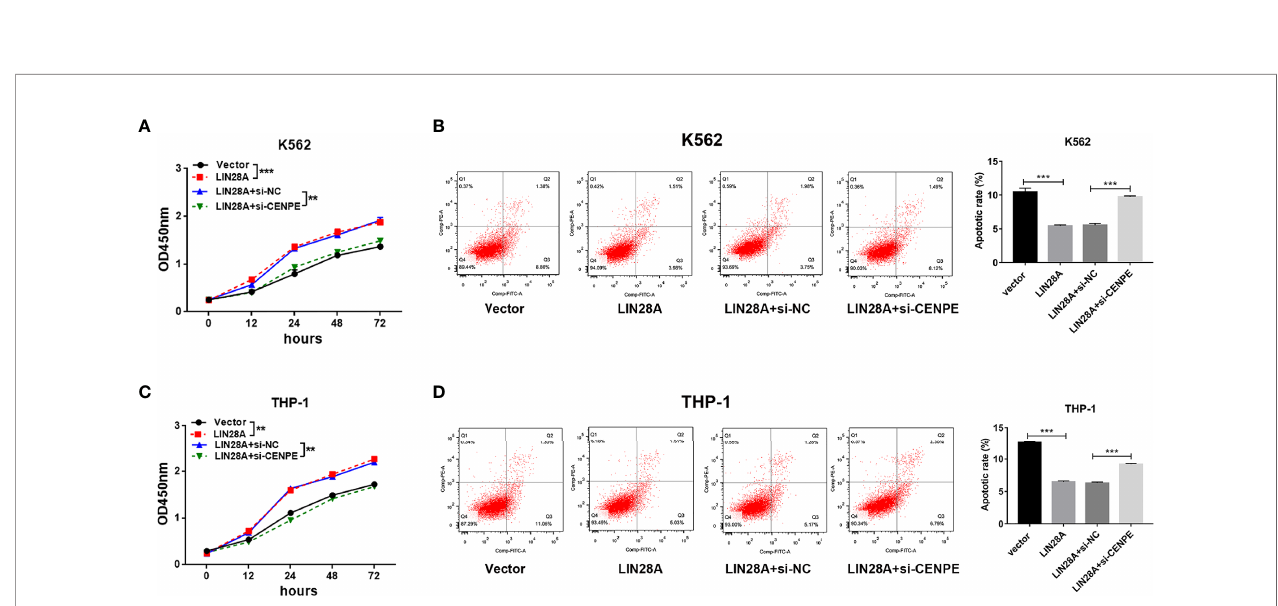
FIGURE 8 | Interaction of LIN28A and CENPE effected cell proliferation and apoptosis in K562 and THP-1 cells. (A) CCK8 assay was used to explore the effect of LIN28A overexpression and CENPE interference on cell proliferation regulated by LIN28A overexpression of K562 cells. (B) After 48 h of transfection, cell apoptosis was measured by Annexin V-FITC/PI double-staining method fl ow cytometry in LIN28A overexpressed and CENPE interfered LIN28A overexpressed K562 cells. The cell apoptotic rates were analyzed in K562 cells. (C) CCK8 assay was used to explore the effect of LIN28A overexpression and CENPE interference on cell proliferation regulated by LIN28A overexpression of THP-1 cells. (D) After 48 h of transfection, cell apoptosis was detected by Annexin V-FITC/PI double-staining method fl ow cytometry in LIN28A overexpressed and CENPE interfered LIN28A overexpressed THP-1 cells. The cell apoptotic rates were analyzed in THP-1 cells. ** p < 0.01. *** p <